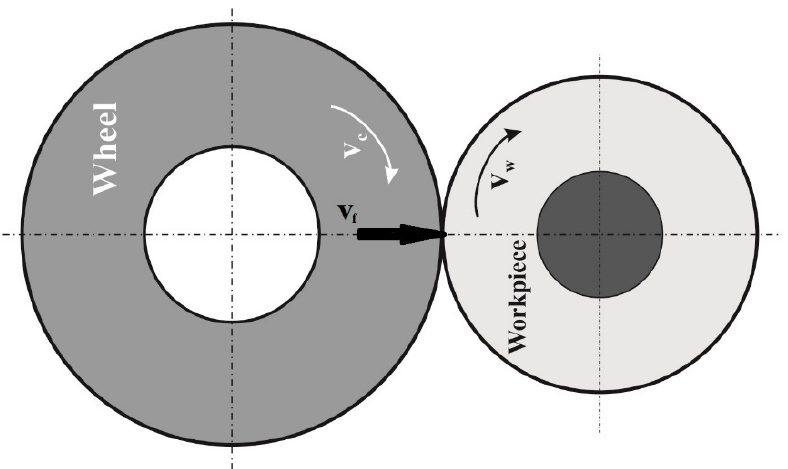
Figure 1. The grinding schema used in the experiment (v c —cutting speed, v f —radial feed of tool, v w —circumferential speed of the workpiece).